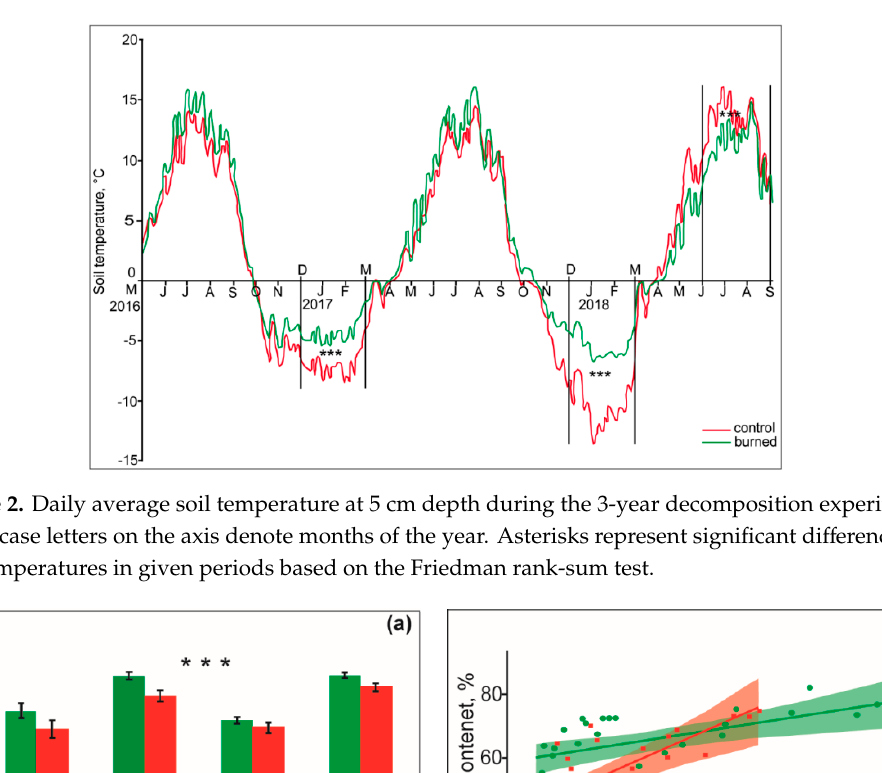
Figure 3. Litterbag water content ( a ) during decomposition experiment. Error bars represent ± SE ( n = 6). Asterisks indicate significant differences (Holm–Bonferroni corrected p < 0.05) during the entire decomposition period, based on a generalized linear mixed model (GLMM) where ‘days’ was set as a random factor. ( b ) Linear relationship between water content and mass loss of the needles during entire decomposition period. Red and green areas represent the 95% confidence intervals in the burned and control stands, respectively.